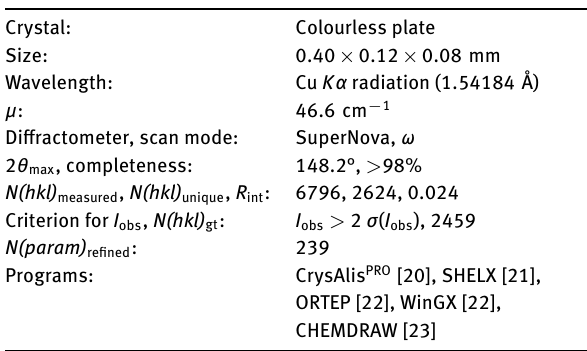
Table 1: Data collection and handling.